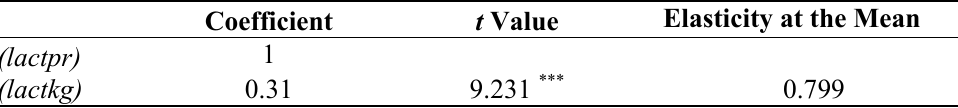
Table 5. Cointegrating